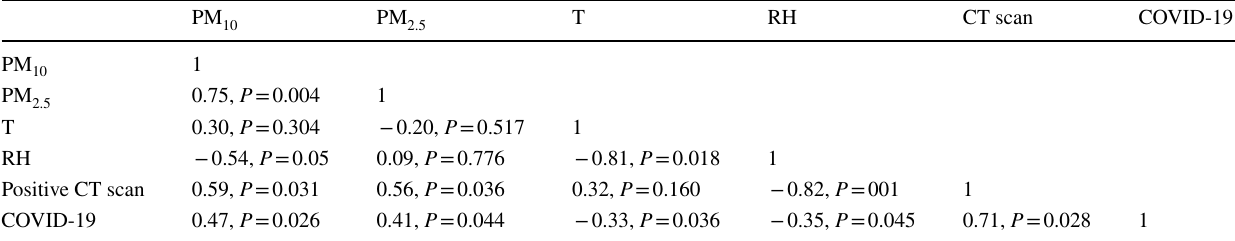
Fig. 2 a Correlation between daily PM P < 0.01) concentrations and ( a ') PM 10 and PM 2.5 ( 2.5 /PM 10 ratio in Ahvaz (Iran) between March 2020 and March 2021 Table 3 Correlation coefficient (Spearman’s test) and significance level ( P ) between daily PM 10 and PM 2.5 mean concentrations, air temperature, relative humidity, the number of positive chest CT scan and COVID-19 cases at